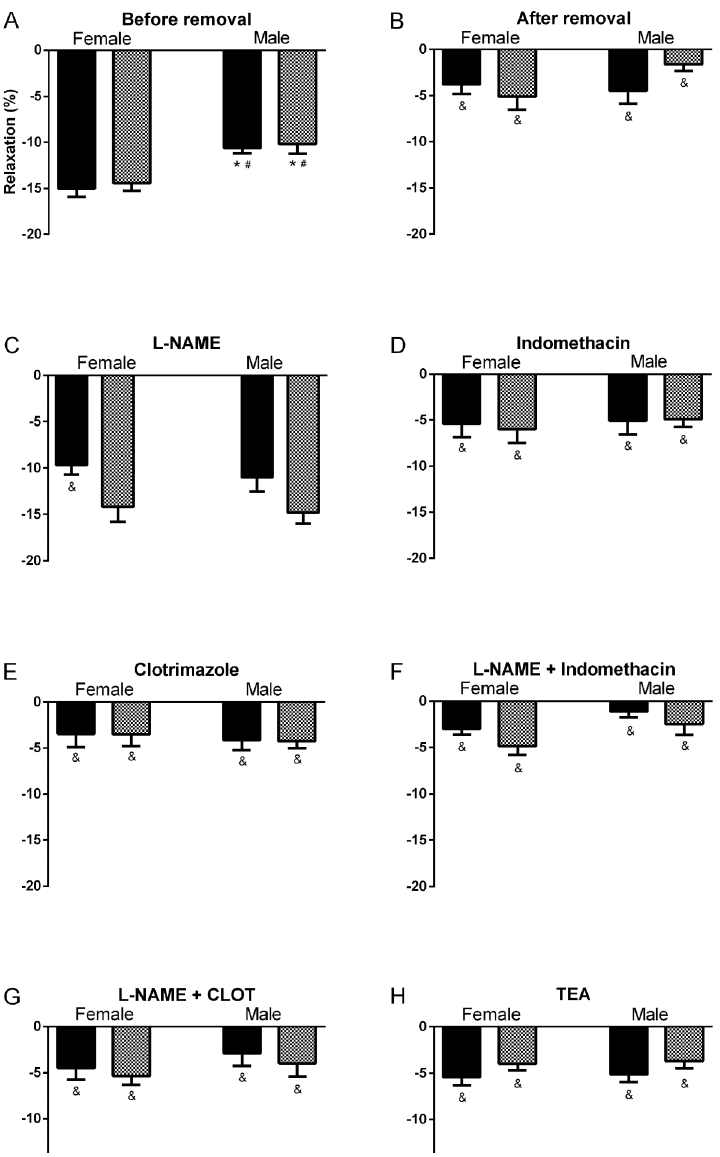
Figure 2. Relaxation responses to 17- (cid:1) -estradiol in the coronary vascular beds of sham-operated and gonadectomized female and male rats before ( A , n=28) and after endothelium removal ( B , n=10) or perfusion with N G -nitro-L-arginine methyl ester (L-NAME) ( C , n=12), indomethacin ( D , n=10), clotrimazole ( E , n=9), L-NAME plus indomethacin ( F , n=10), L-NAME plus clotrima- zole (CLOT; G, n=9), or tetraethylammonium (TEA; H , n=9). Data are reported as means ± SE. *P o 0.05 compared to the sham-operated females, # P o 0.05 compared to the gonadectomized females, and & P o 0.05 compared to the same group under control conditions (before endothe- lium removal, A ) (two-way ANOVA and Tukey ’ s post hoc